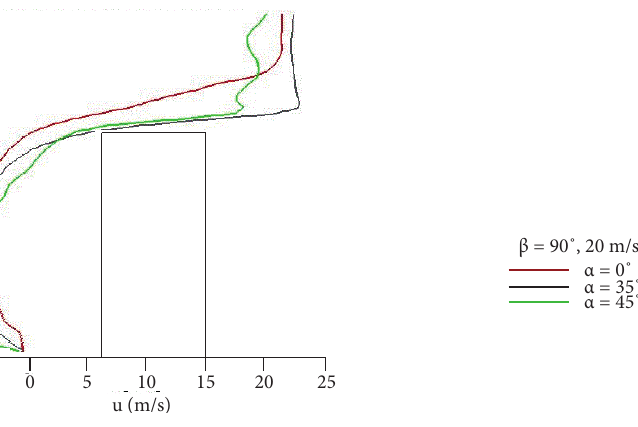
Figure 20. Velocity profi les in the MIT region for β =